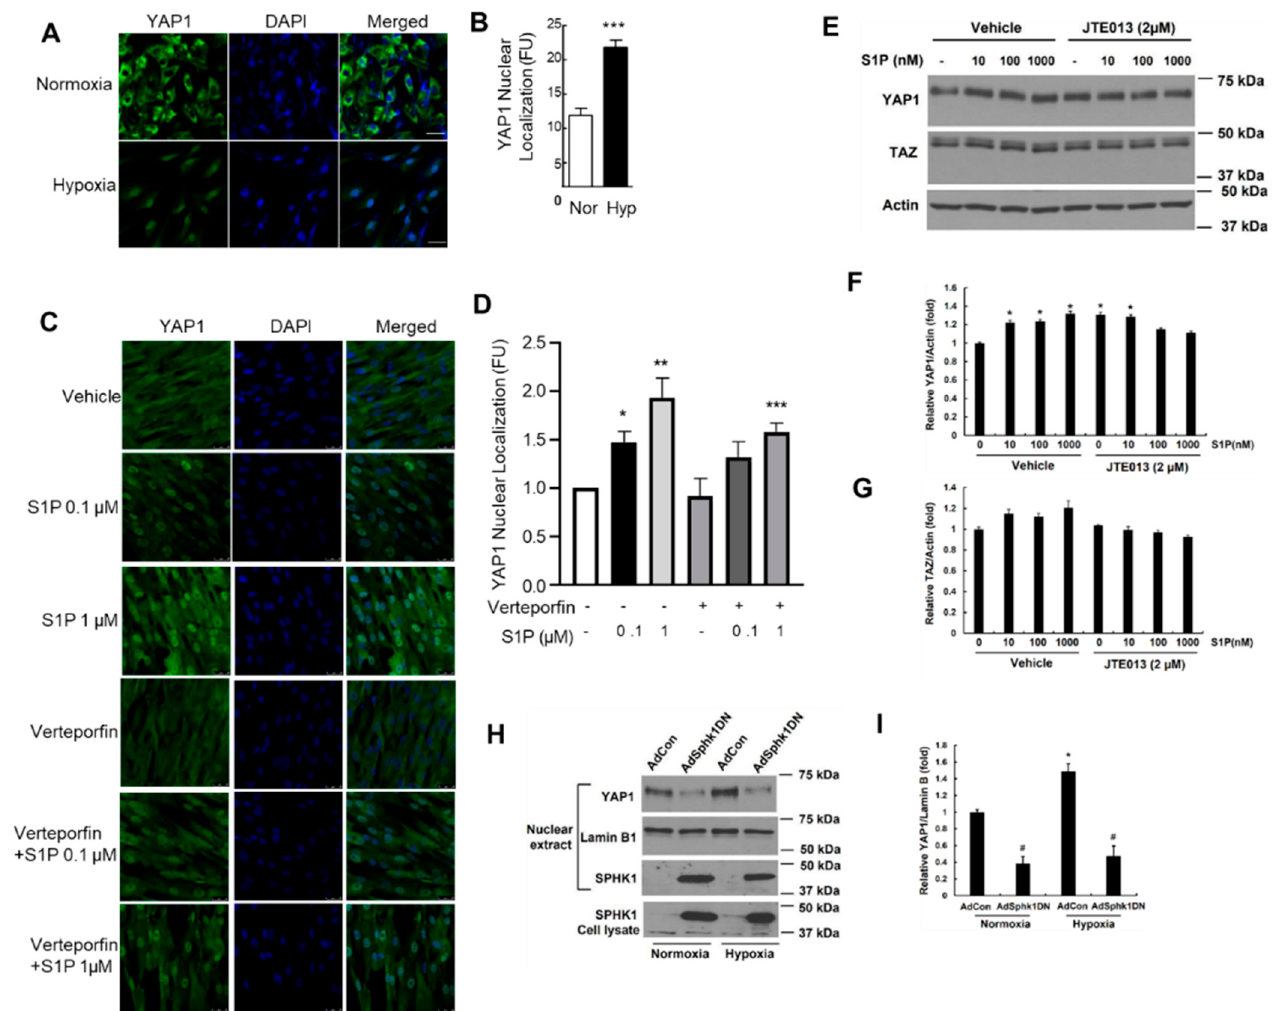
Figure 6. Hypoxia and S1P stimulate YAP1 nuclear translocation and verteporfin attenuates S1P-mediated YAP1 nuclear translocation in PASMCs. Exposing hPASMCs to hypoxia (3%, 30 min) significantly increased YAP1 translocation to the nucleus as determined by immunofluorescence ( A ), and nuclear YAP1 expression levels were quantified and are shown in ( B ). Similarly, the S1P (0.1 µ M and 1 µ M) treatment of PASMCs for 30 min induced YAP1 nuclear translocation, an effect that was abrogated by the pretreatment of cells with verteporfin (100 nM for 1 h), followed by an S1P challenge for 30 min ( C , D ). hPASMCs were pretreated with the S1PR2 antagonist JTE-013 (2 µ M) for 1 h followed by S1P (10-1000 nM) challenge for 24 h. YAP1 and TAZ expressions were determined by Western blotting, and a representative blot is shown ( E ) and quantified by image analysis, and it is normalized to the total actin for YAP1 ( F ) and TAZ ( G ). hPASMCs were transfected with adeno control vector or SPHK1 dominant mutant (5 MOI, 24 h) prior to exposure to normoxia or hypoxia (3%, 2 h). Cells were subjected to the isolation of their nuclei using a commercial kit; subjected to Western blotting; and probed with anti-YAP1, anti-Lamin B, and anti-SPHK1 antibodies. The baseline and hypoxia-induced nuclear localization of YAP1 were reduced in hPASMCs transfected with SPHK1DN adenoviral plasmid compared with cells transfected with a control plasmid ( H , I ). n = 3–5. * p < 0.05 versus normoxia or vehicle control; ** p < 0.01 versus vehicle control; *** p < 0.05 versus S1P; # p < 0.05 versus vector control. Scale bar: 25 µ